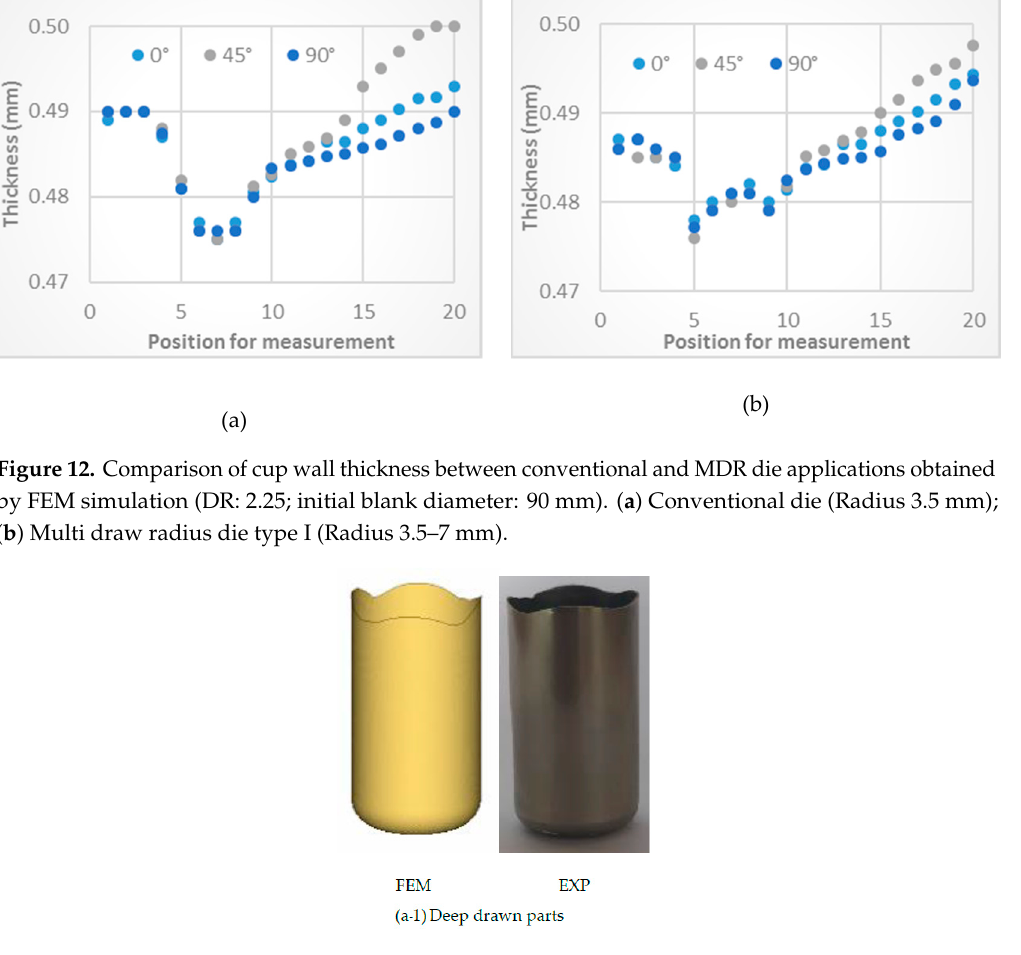
Figure 11. Multi draw radius die application with respect to various DRs: ( a ) DR: 2.75 (Ø Initial blank 110 mm); ( b ) DR: 2.88 (Ø Initial blank 115 mm).